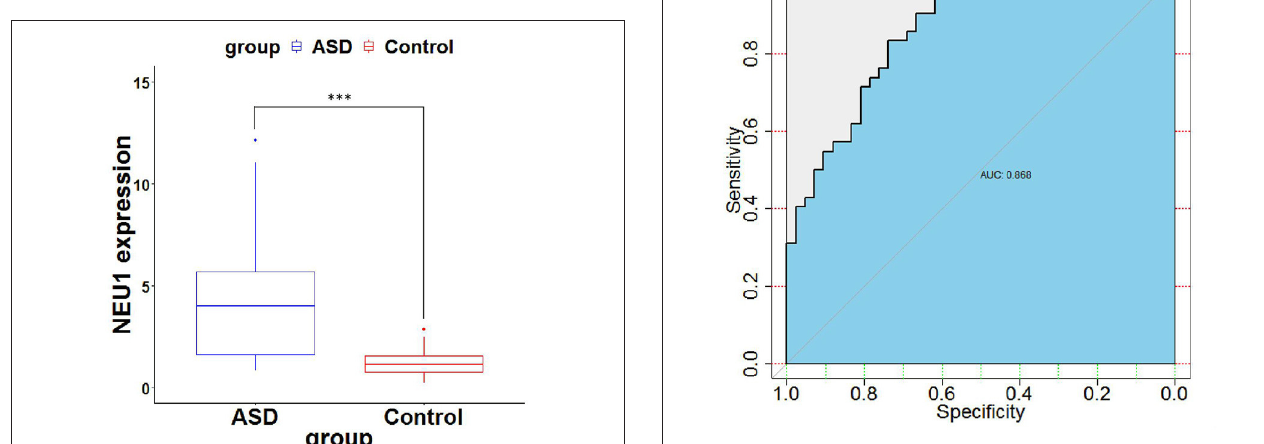
FIGURE 1 | NEU1 mRNA expression (2 − 11 Ct values) of ASD and Control. P -values were calculated using the Mann-Whitney U test. *** , significant difference between ASD group and control group.